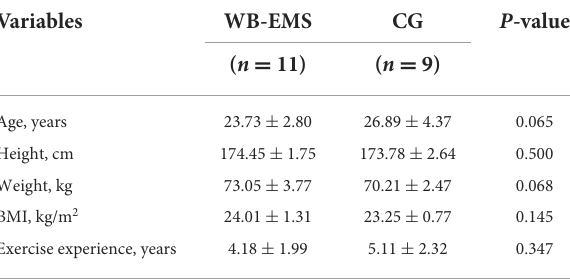
TABLE 1 Baseline characteristics of experimental